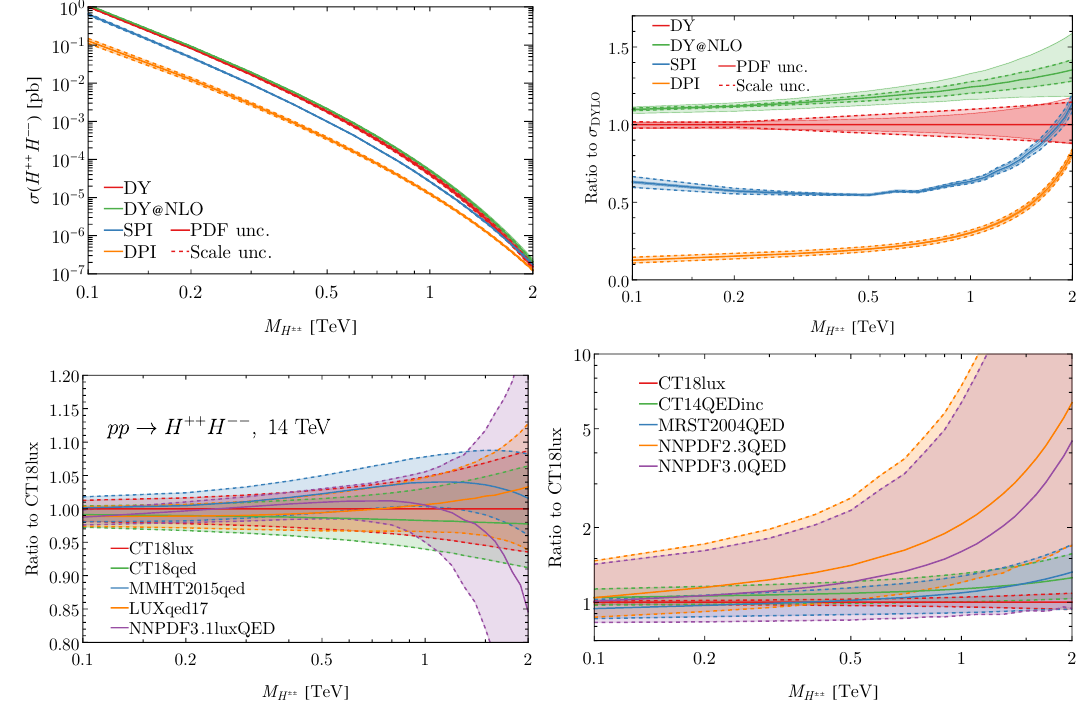
Figure 4: The cross sections for H ±± pair production at a 14 TeV proton-proton col-